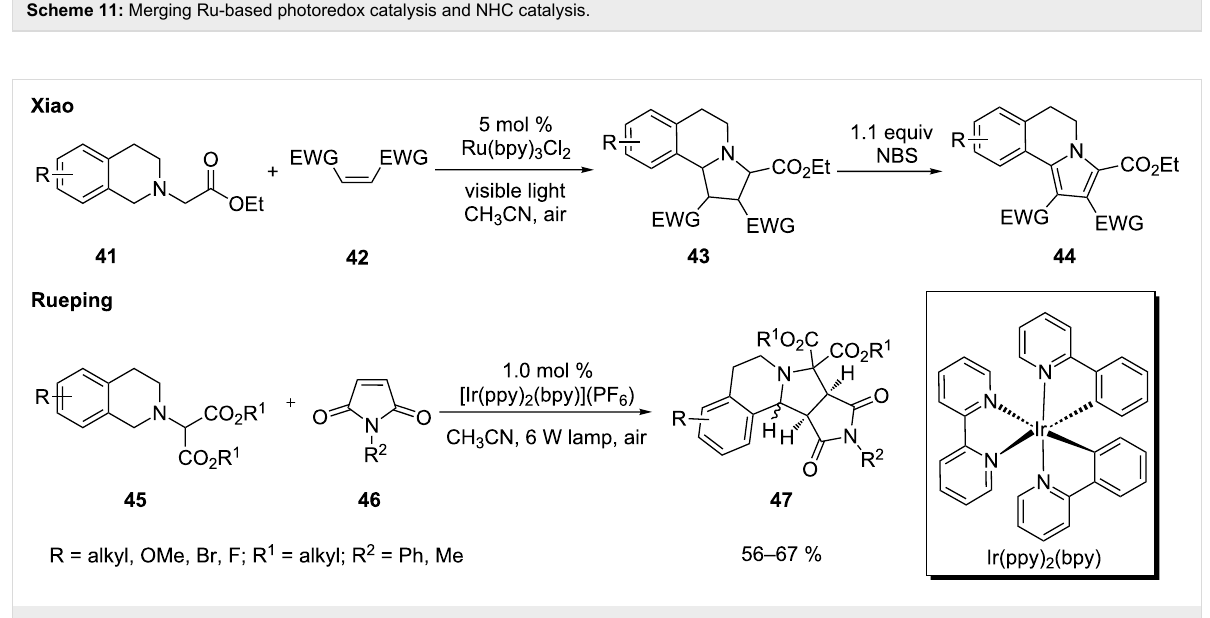
Scheme 12: 1,3-Dipolar cycloaddition of photogenically formed azomethine ylides.